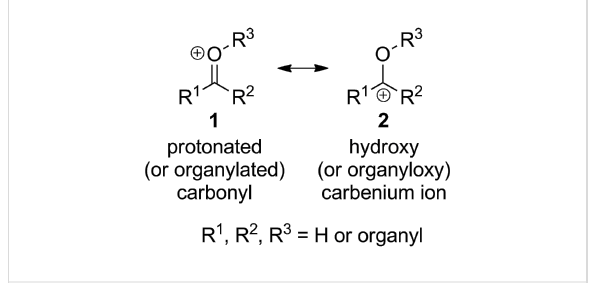
Figure 1: Protonated (or organylated) carbonyl ( 1 ) and hydroxy (or organyloxy) carbenium ion ( 2 ): two possible representations of the same